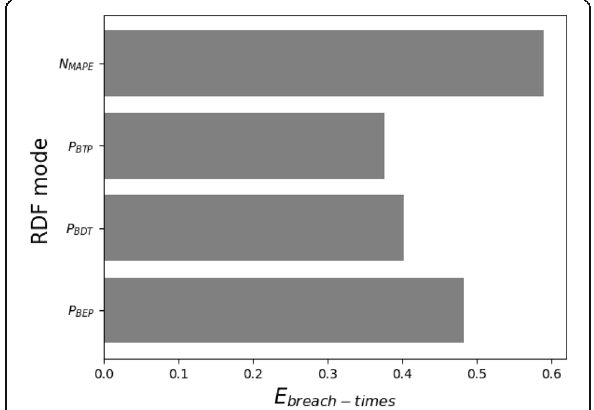
Fig. 12 Ebreach-extent of N-mode and P-mode models